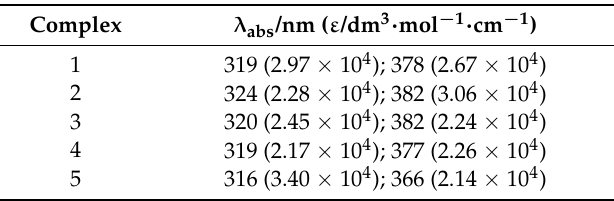
Figure 1. UV–Vis spectra of Complexes 1 – 5 (3.59 × 10 − 6 mol · dm − 3 in CH 2 Cl 2 ). Table 1. UV–Vis Spectra Data of Complexes 1 – 5 in CH 2 Cl 2 . Table 1. UV–Vis Spectra Data of Complexes 1 – 5 in CH 2 Cl 2 Table 1. UV–Vis Spectra Data of Complexes 1 – 5 in CH 2 Cl 2 .